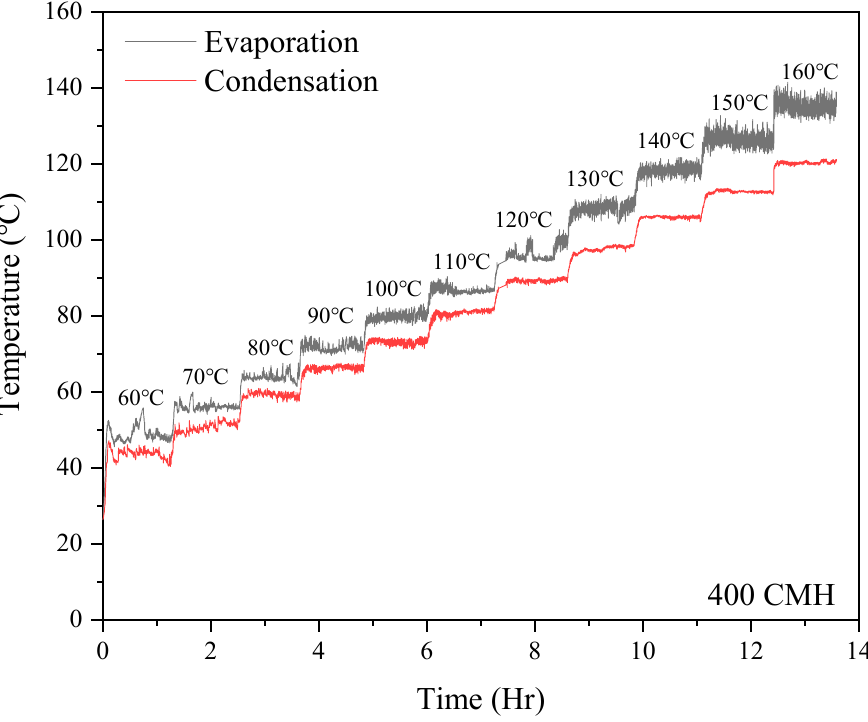
Figure 4. The histories of evaporator and condenser temperatures with increasing heating pool temperature under a cooling air flow rate of 400 CMH.